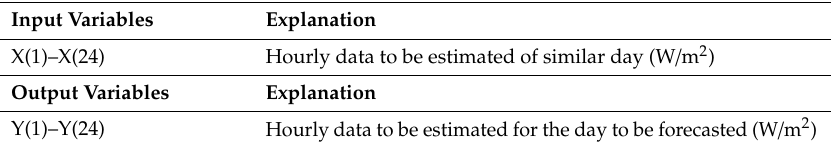
Table 4. Input and output variables of ANN.